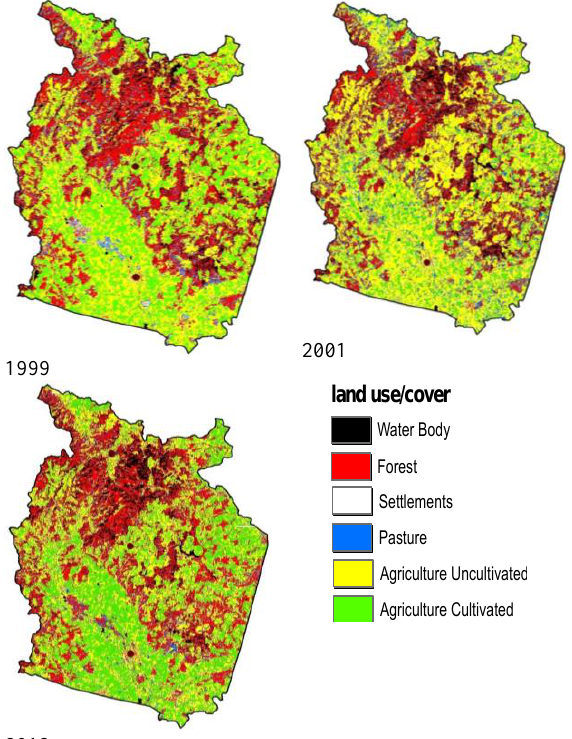
Figure 2. Land Cover change for 1991, 2001 and